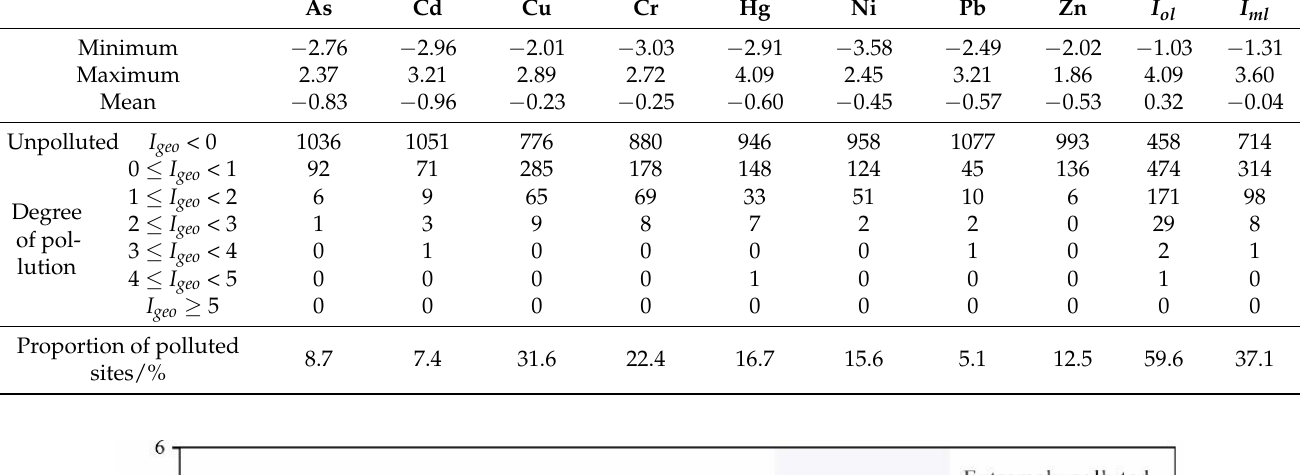
Table 4. Results obtained for evaluations using a heavy metal geoaccumulation index. As